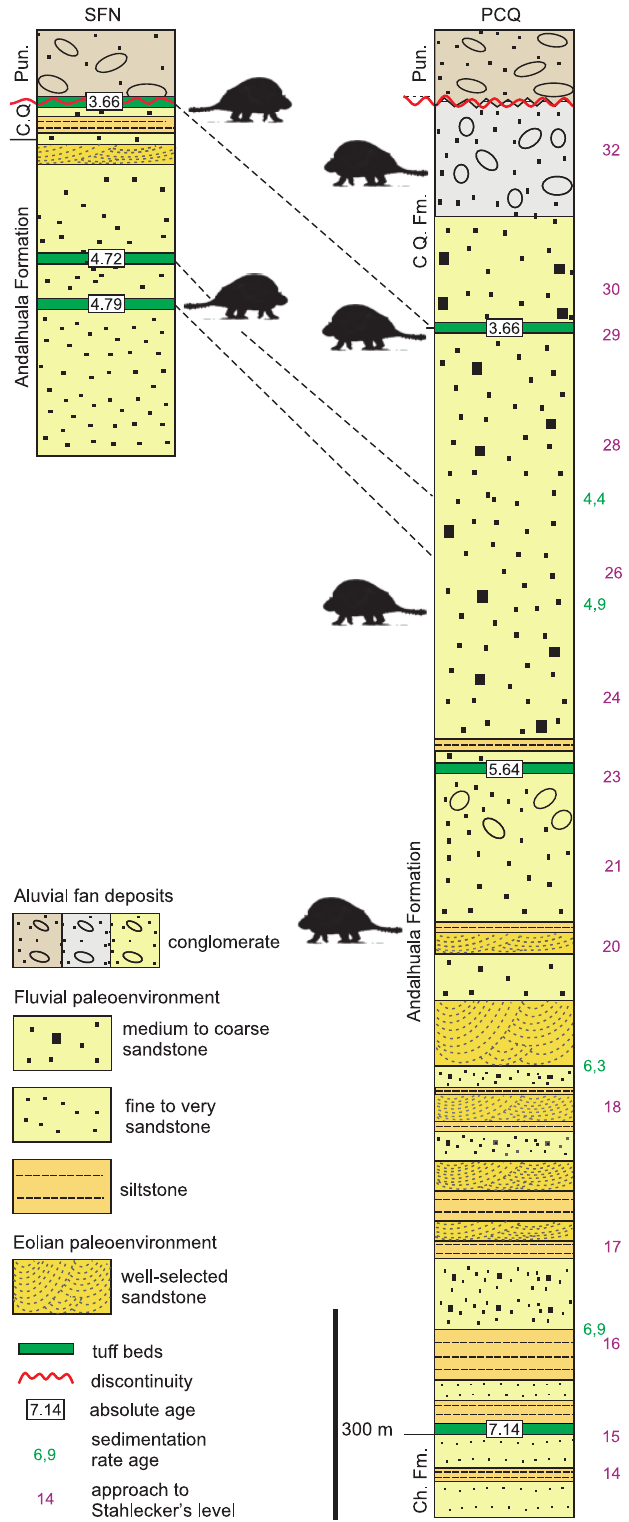
Fig. 2. Lithostratigraphic, chronological, and paleoenvironmental synthesis of San Fernando Norte and Puerta de Corral Quemado sections showing the stratigraphical and chronological distribution of Eleutherocercus solidus Rovereto, 1914 (modified from Georgieff et al. 2017; Bonini et al. 2020). Abbreviations: Ch. Fm., Chiquimil Formation; CQ. Fm., Corral Quemado Formation; Pun.,